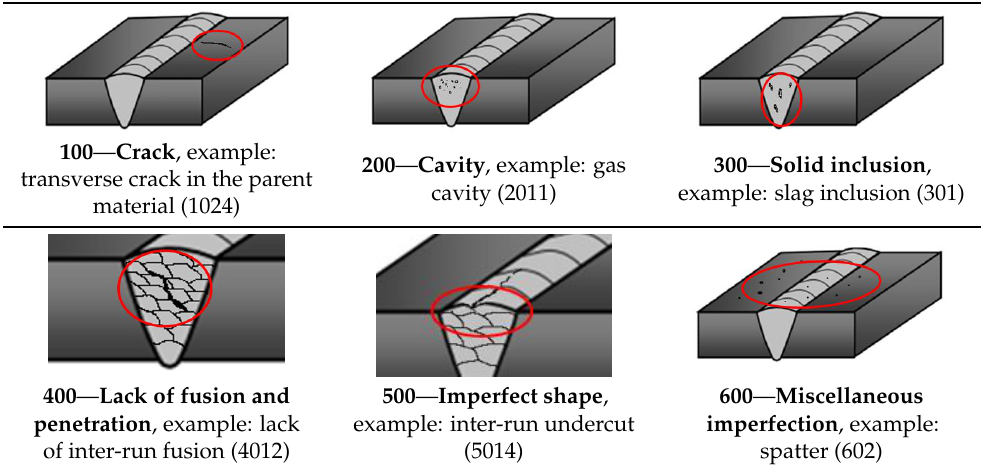
Table 1. Main imperfections and examples (according to ISO 6520-1 [33]). List of the main groups of imperfections, their corresponding group numbers and descriptions, as well as an example of each imperfection with an accompanying figure are included.